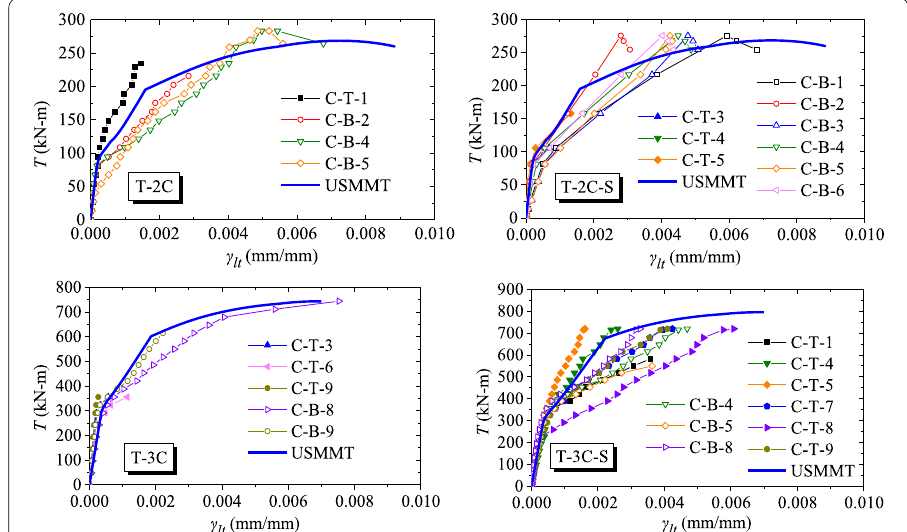
a Due to the limitation of test methods, this specimen may not actually reach the ultimate torque